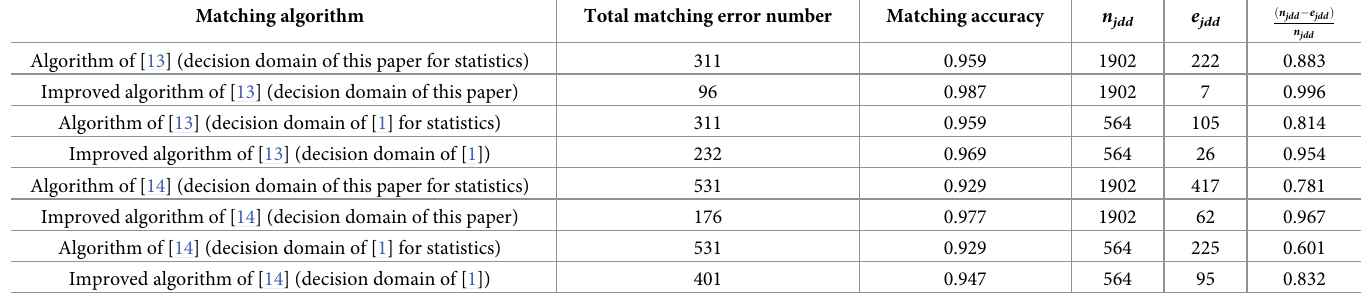
Table 1. Test result of DS